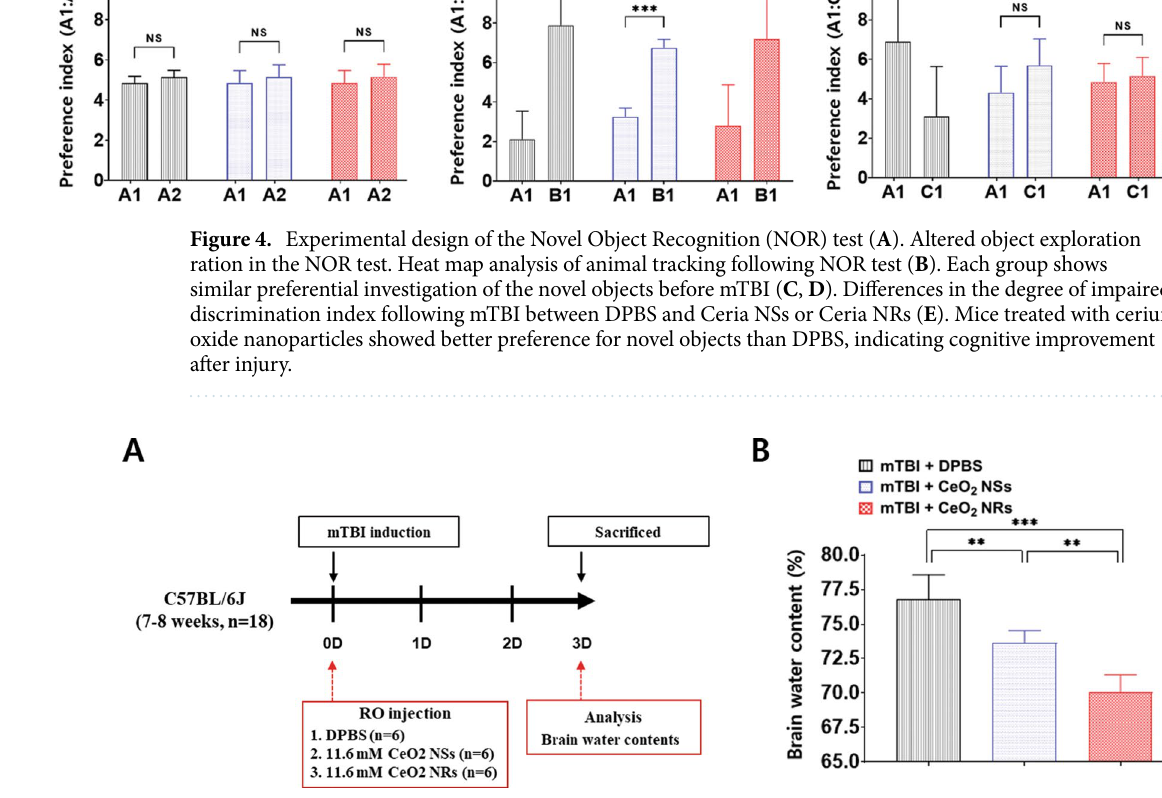
Figure 5. Schematic diagram depicts brain water content analysis of the degree of cerebral edema ( A ). Comparison of brain water content in the three groups: DPBS, Ceria NSs, and Ceria NRs. Error bars, mean SEM, ** P < 0.01, and *** P <